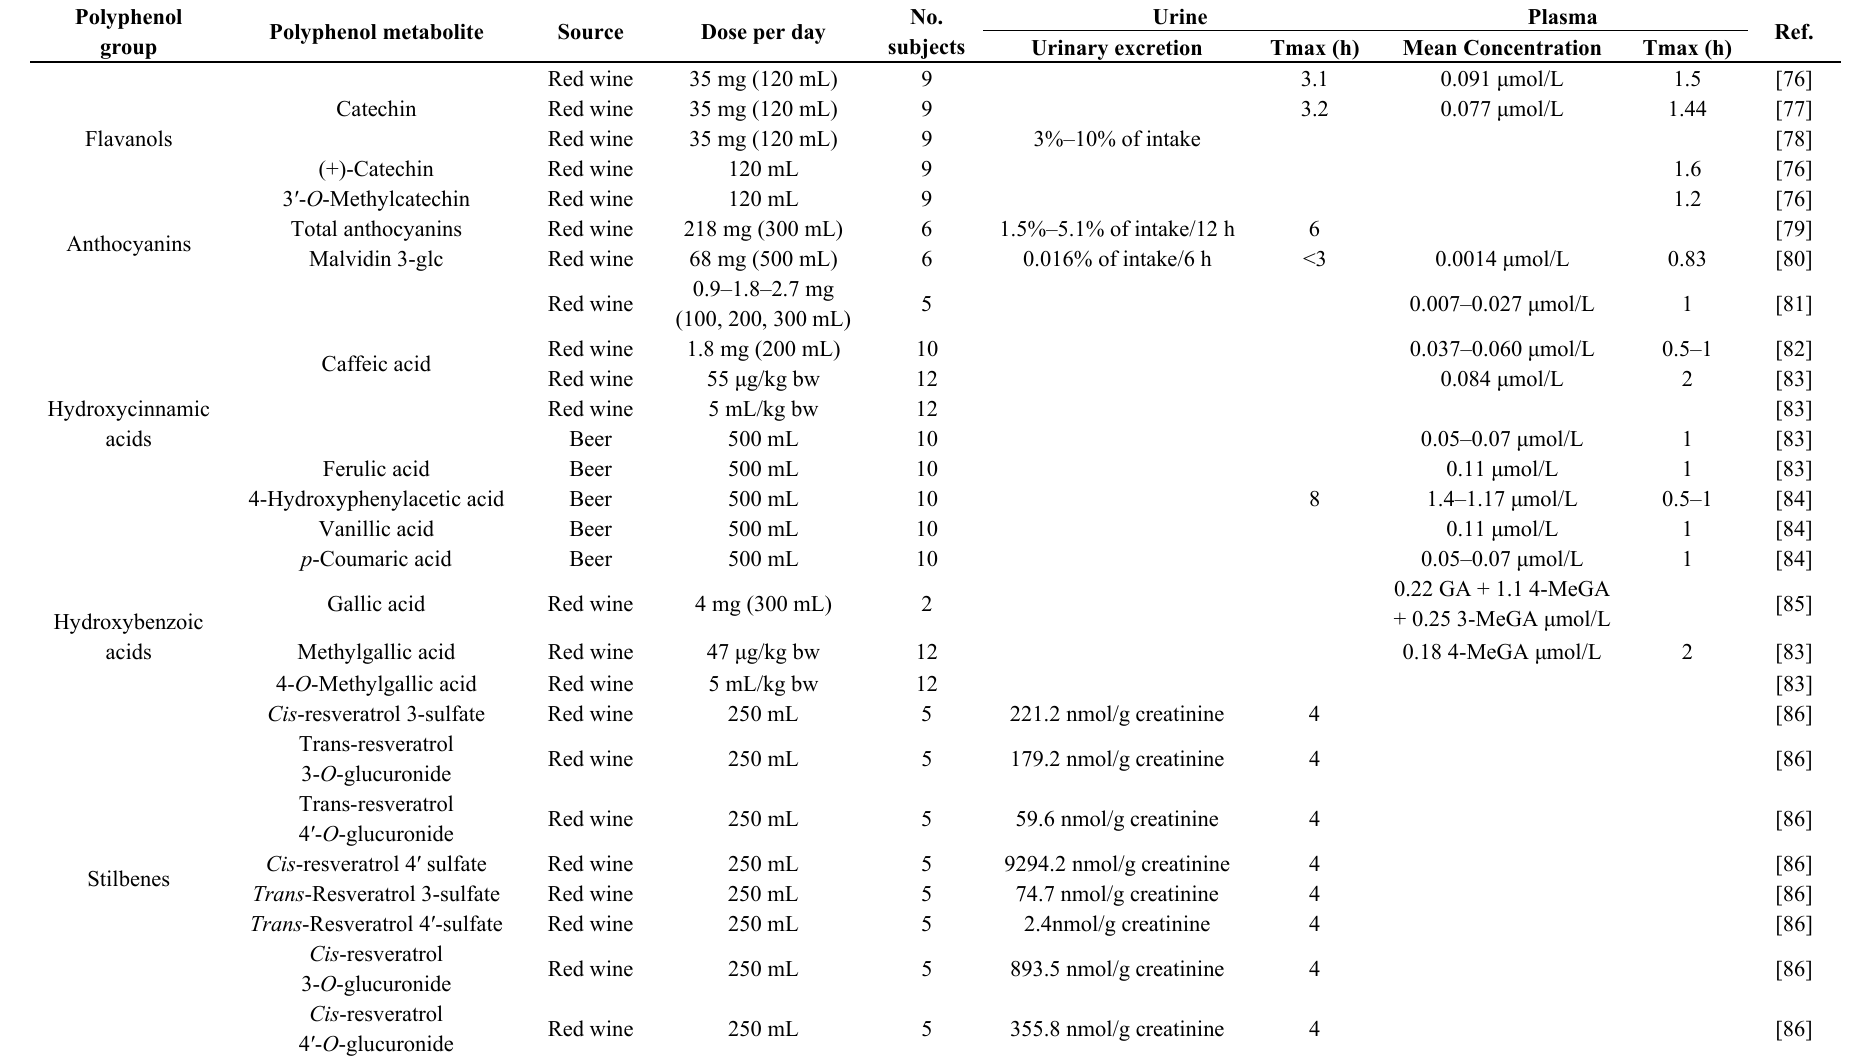
Table 3. Main polyphenolic metabolites described in literature from wine and